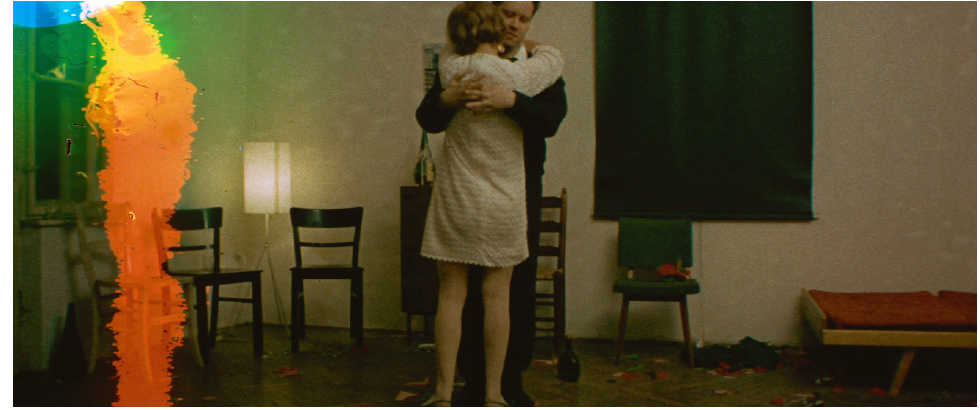
Figure 3: Film still of analogue copy with coloured stains and